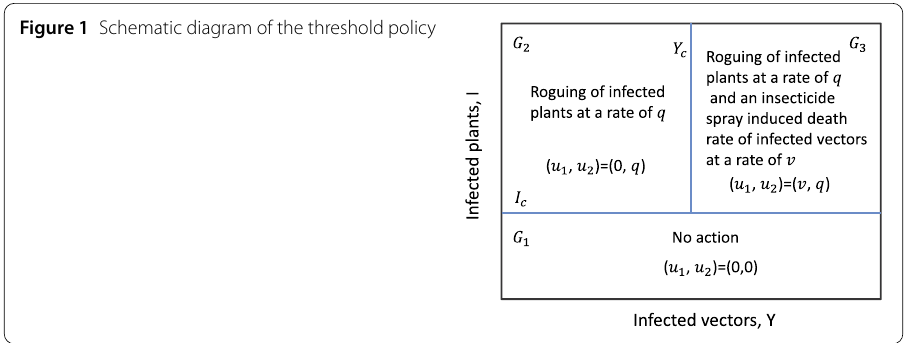
Figure 1 Schematic diagram of the threshold